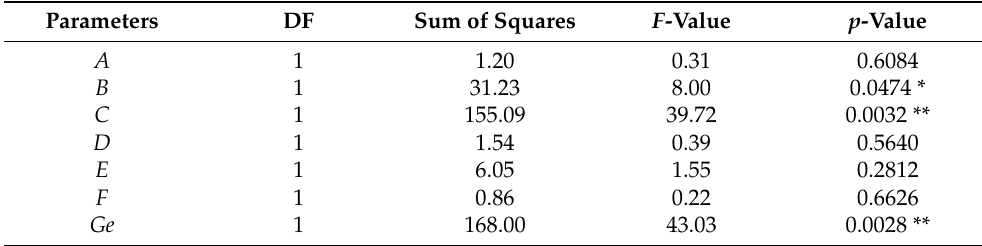
Table 7, G (JKR surface energy) and C (powder–powder rolling friction coefficient) have p < 0.01, which has highly significant effects on the rest angle of the simulation test; B